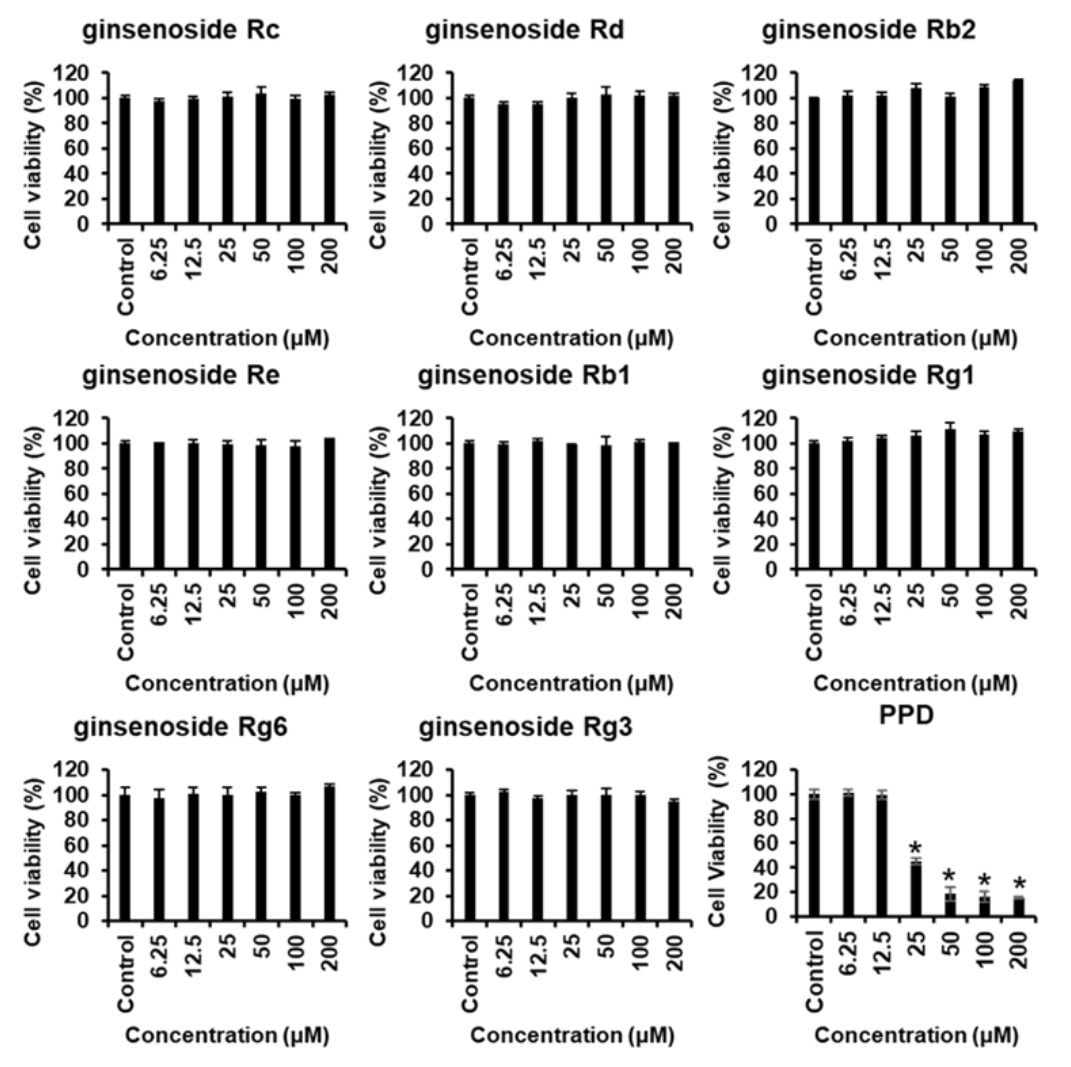
Figure 3. Cytotoxicity of ginsenosides and PPD on HUVECs. The HUVECs were treated with ginsenosides or PPD at various concentrations (6.25–200 µ M) or with 0.5% dimethyl sulfoxide only (control) for 24 h, followed by the evaluation of cell viability by the EZ-Cytox assay. Data are presented as the mean ± standard deviation (SD) of three independent experiments. * p < 0.05 compared to the control